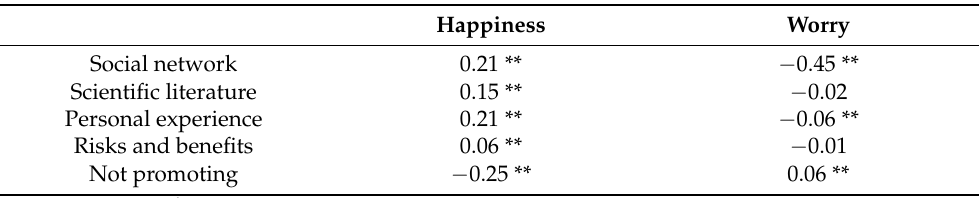
Table 4. Correlational analysis. Different modalities of vaccine promotion and emotions of happiness and worry after vaccination. Happiness Worry Social network 0.21 ** − 0.45 ** Scientific literature 0.15 ** − 0.02 Personal experience 0.21 ** − 0.06 ** Risks and benefits 0.06 ** − 0.01 Not promoting − 0.25 ** 0.06